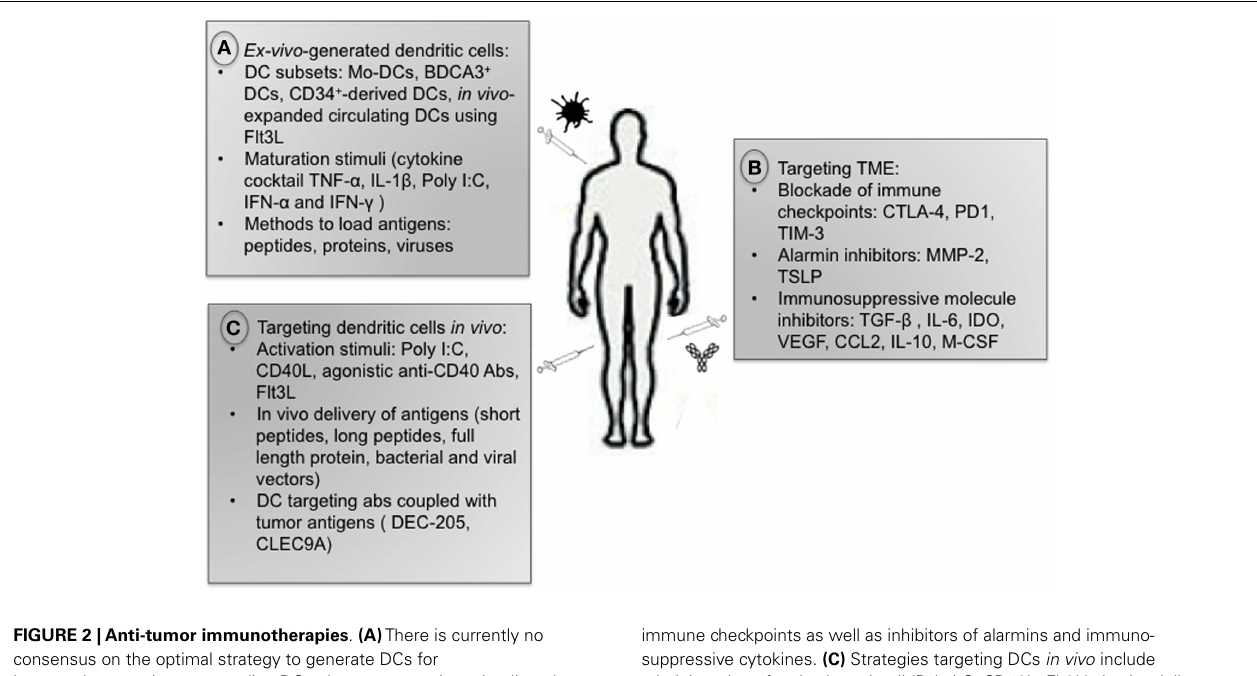
FIGURE 2 |Anti-tumor immunotherapies . (A) There is currently no consensus on the optimal strategy to generate DCs for immunotherapeutic use regarding DC subsets, maturation stimuli, and methods to load antigens. (B) Therapies aiming at reprograming the immuno-suppressiveTME are very promising, including blockade of